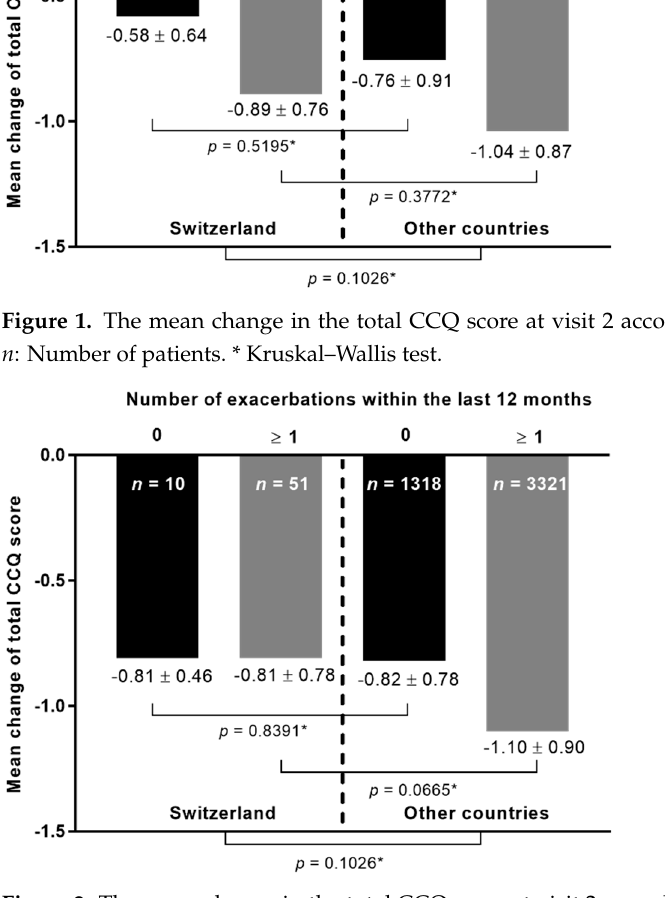
Figure 1. The mean change in the total CCQ score at visit 2 according to baseline mMRC grade. n : Number of patients. * Kruskal–Wallis test.